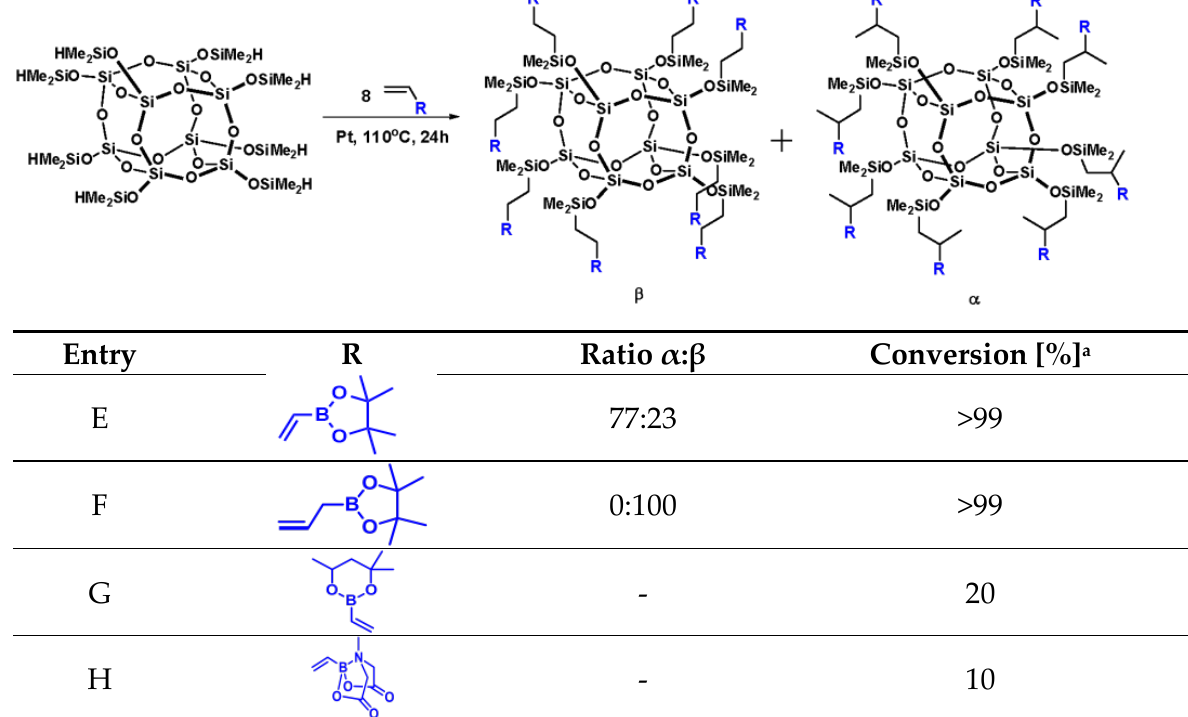
Figure 2. Selectivity and conversion of hydrosilylation reactions with SS-8H.